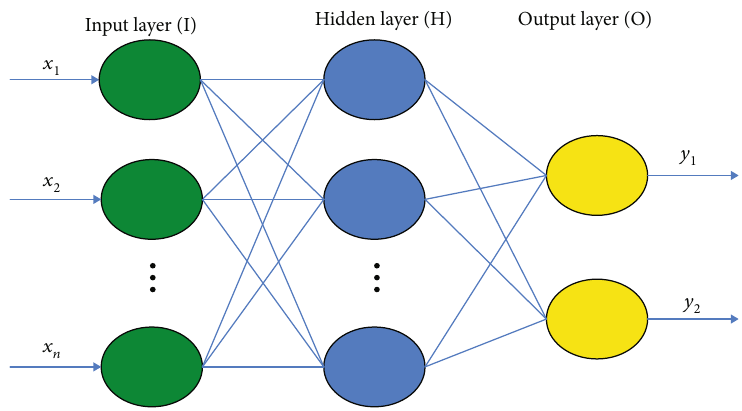
Figure 2: The structure of the BP neural